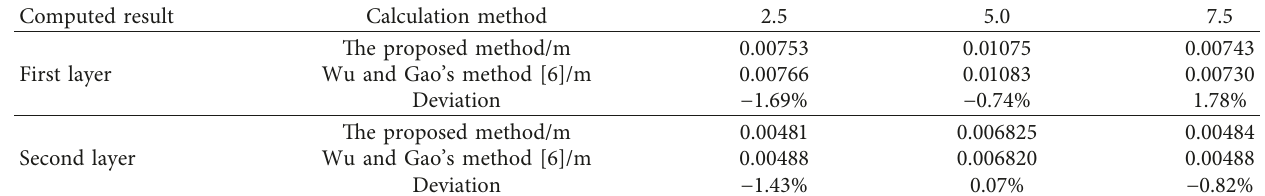
Table 2: Comparison of dynamic response peaks at the positions of x � 2.5m, 5.0m, and 7.5m.